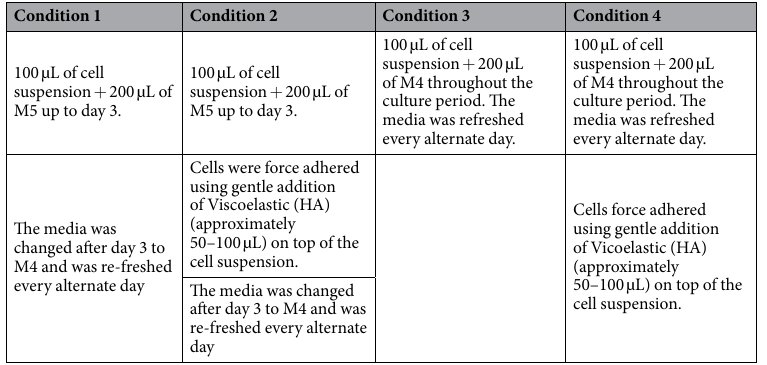
Table 2. Description of plating conditions. Condition 1, 2, 3 and 4 shows different plating characteristics with and without HA and ROCK. In condition 1, no HA or ROCK was used to check the behaviour of the cells without the influence of these extra parameters. In Condition 2, only HA was added to check the adherence of the cells without ROCK. Condition 3 only utilized ROCK inhibitor from the day of plating to check the effect of ROCK inhibitor directly on the cells. Condition 4 was a mixture of HA and ROCK to understand the influence of both the parameters